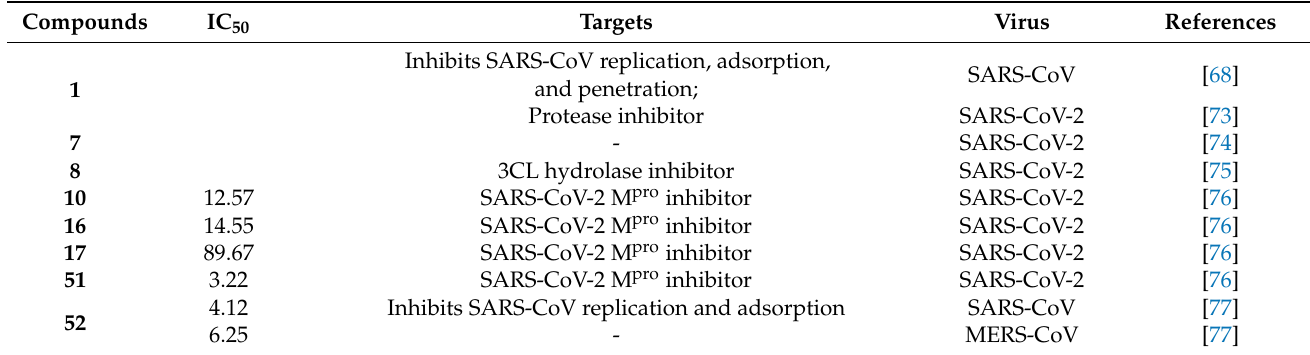
Table 3. Summary of anti-CoV triterpenoids and their targets and activities.